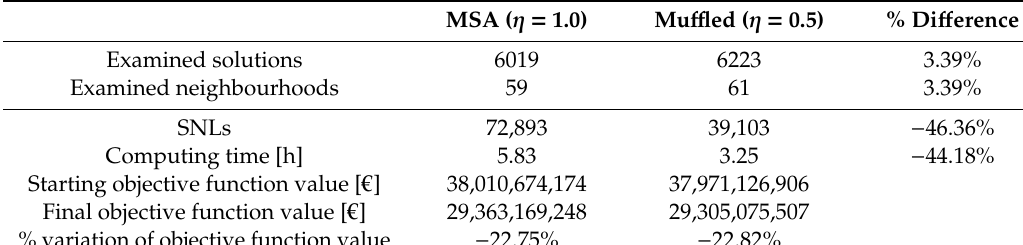
Table 10. Comparison between algorithms.